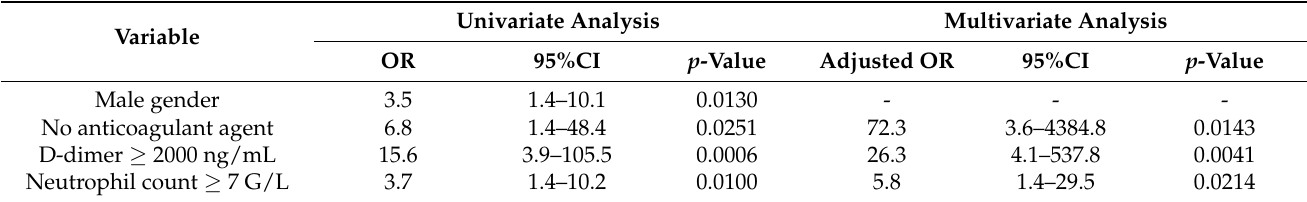
Table 3. Predictive factors of pulmonary embolism during the hospitalization in medicine ward.